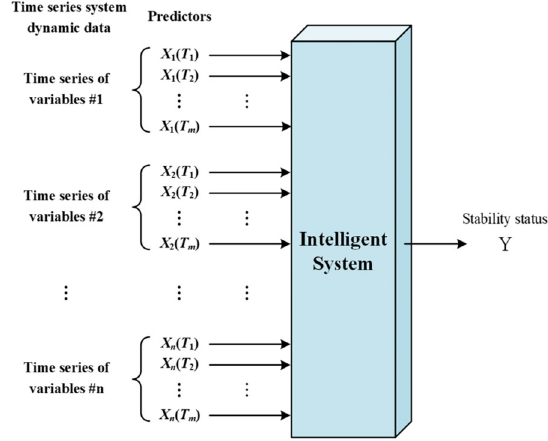
Fig. 1 Illustration of an IS for Post-Disturbance